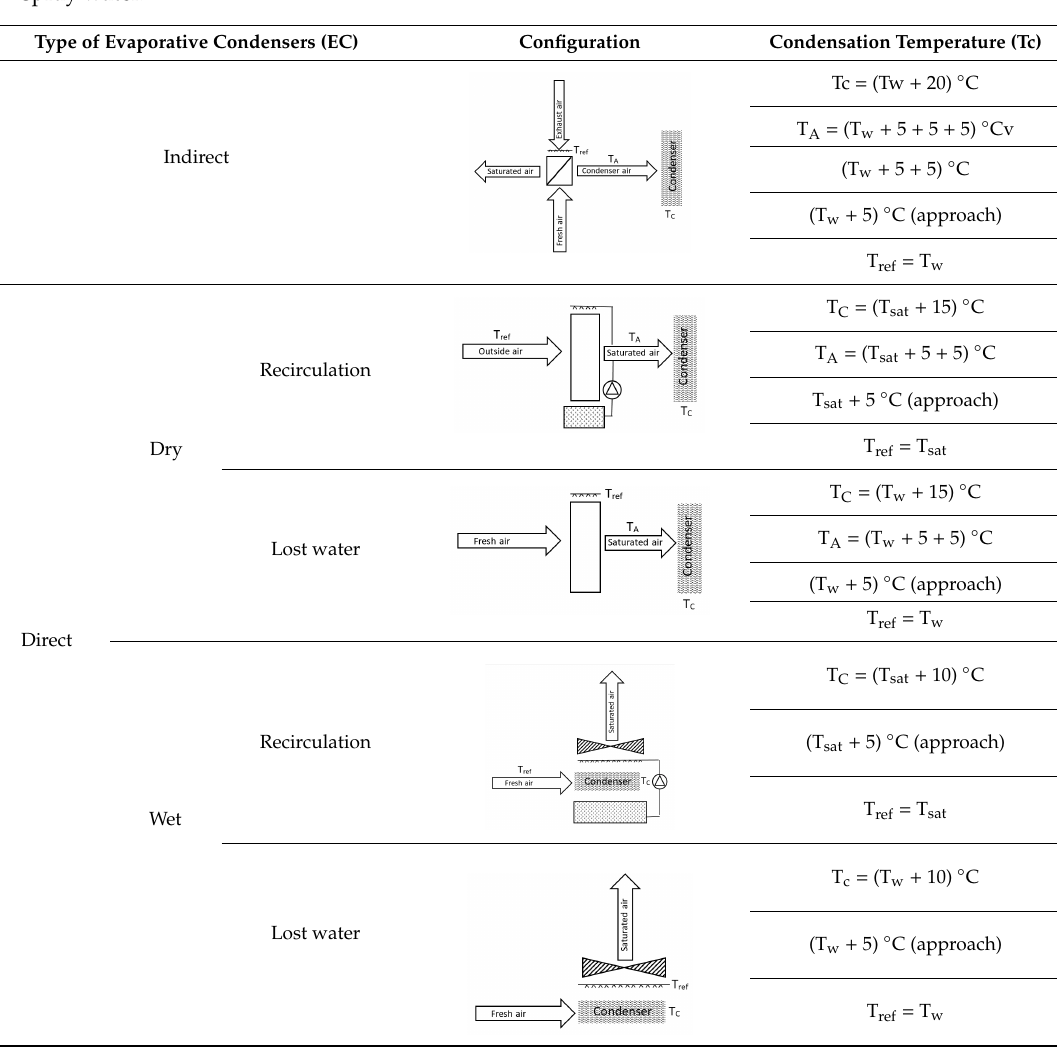
Table 1. Evaporative condenser types and condensation temperature over saturation temperature or spray water.